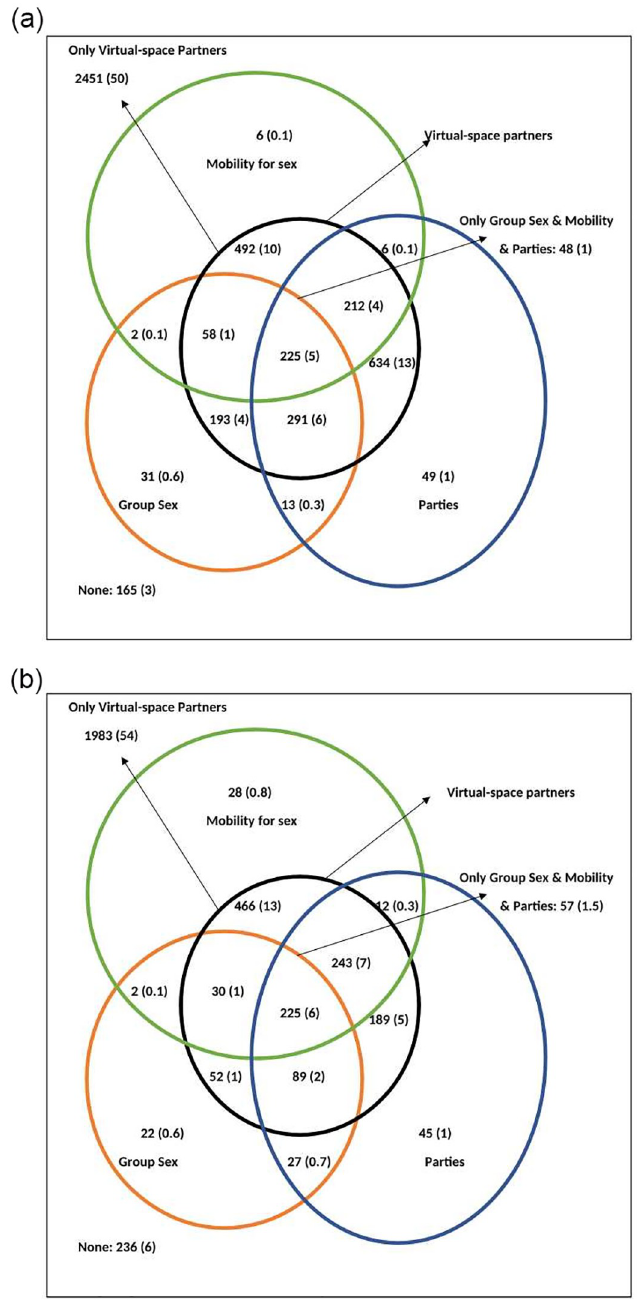
Fig 3. a. Venn diagram showing the distribution and overlap of various behaviours (partners from virtual space, group sex, mobility for sex, attend parties) in men who have sex with men who identify as double-deckers (DDs), Mumbai, India. b. Venn diagram showing the distribution and overlap of various behaviours (partners from virtual space, group sex, mobility for sex, attend parties) in men who have sex with men who identify as kothis , Mumbai, India.